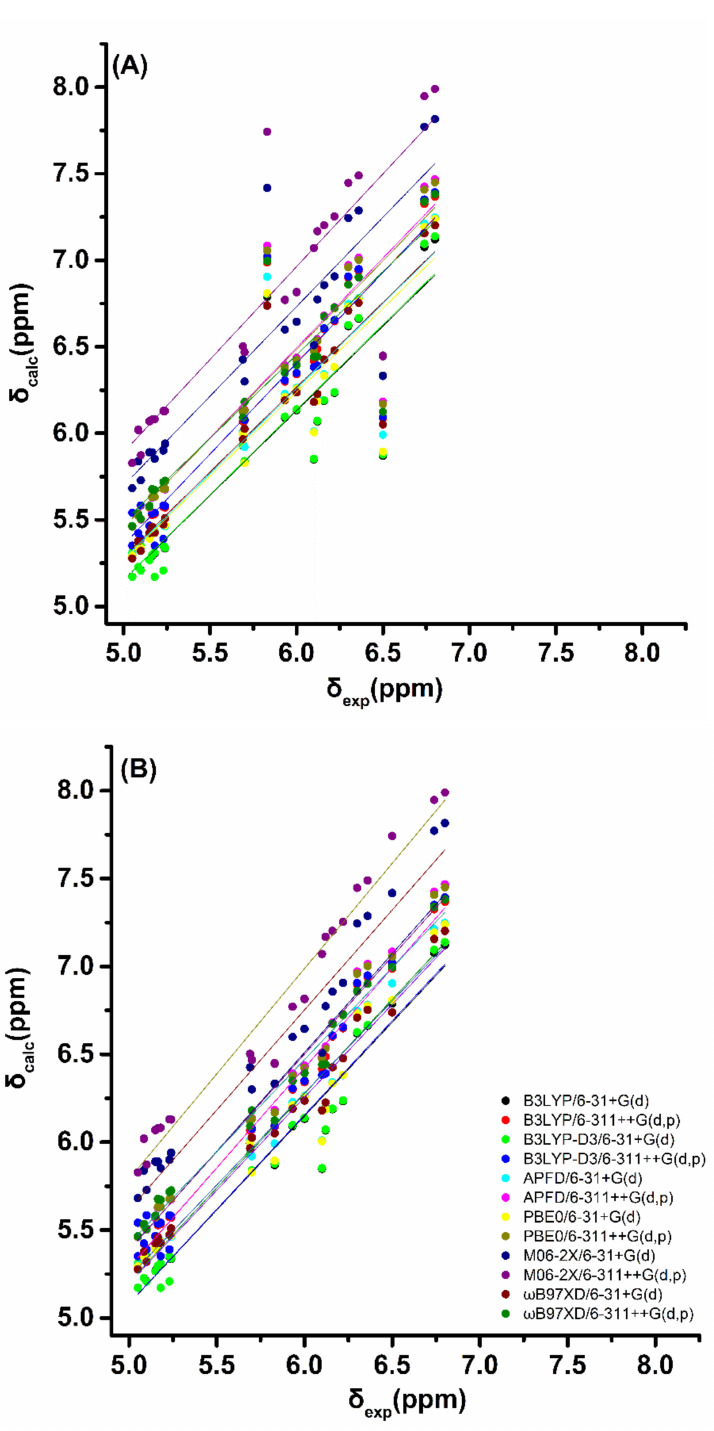
Figure 2. ( A ) Calculated, δ calc , 1 H NMR chemical shifts with CPCM of the olefinic protons vs. experi- mental, δ exp , chemical shifts using the same level of theory as geometry optimization for the model trienyl compounds ( Z )-1,3,5-hexatriene, ( E )-1,3,5-hexatriene, ( E,Z,E )-2,4,6-octatriene, and ( E,E,E )- 2,4,6-octatriene. ( B ) The same as in (A), but the literature experimental values of δ (H (3,6)) = 5.83 ppm and δ (H (4,5)) = 6.50 ppm of ( E,Z,E )-2,4,6-octatriene [23] have been